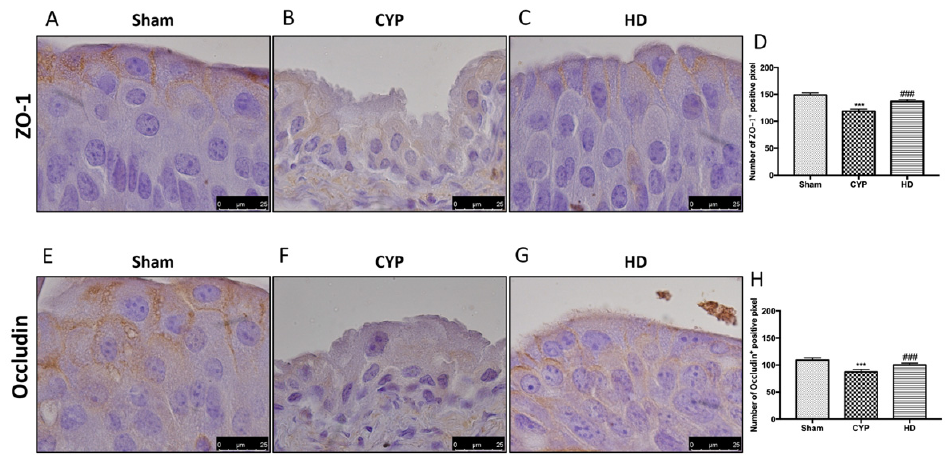
Figure 5. Effect of HD treatment on ZO-1 and occludin expression after chronic cystitis. Immunohistochemical analysis showed a significant loss of ZO-1-positive cells ( B , D ) compared to Sham mice ( A , D ). Animals treated with HD revealed an increase in the expression of ZO-1 ( C , D ). Immunohistochemical analysis for occludin displayed a significant loss of occludin-positive cells ( F , H ) compared to Sham mice ( E , H ). Mice treated with HD revealed an increase in the expression of occludin ( G , H ). Data are expressed as the number of ZO-1-positive pixel and occludin-positive pixels and are the means ± SD of five animals for each group. *** p < 0.001 vs. Sham; ### p < 0.001 vs. CYP.